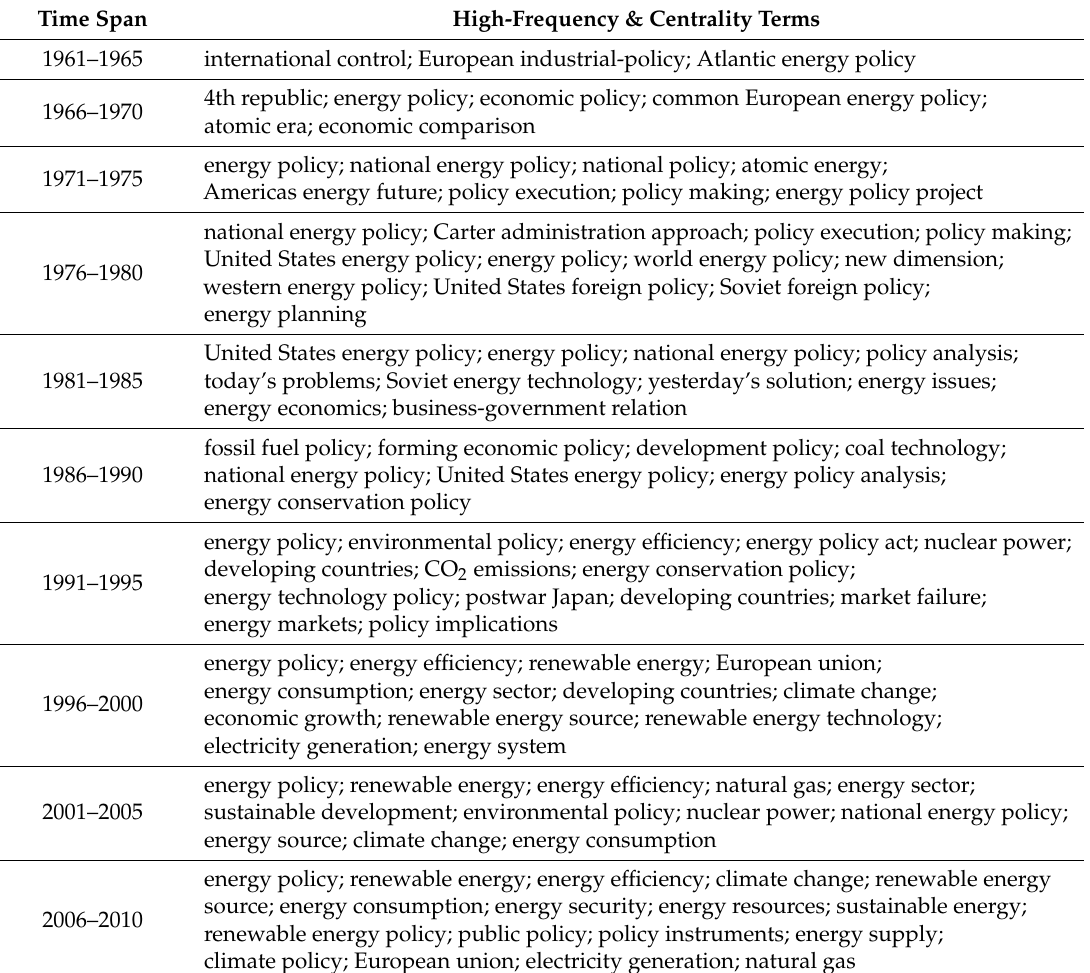
Table 4. High frequency and centrality terms during each five